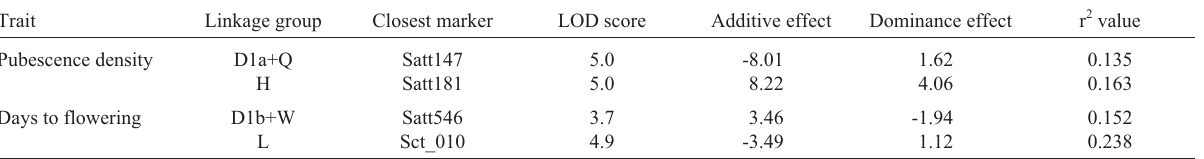
Table 1 - Positions and effects of quantitative trait loci (QTL) detected in the F 2 progeny of the Fukuyutaka x Himeshirazu cross. The Logarithm of odds (LOD)scorethresholdforQTLdetectionwas3.52forpubescencedensityand3.68forfloweringtime.Fortheadditiveeffectifthelocusisfixedwiththe maternal Fukuyutaka parent allele the trait value increases by the indicated value from the intermediate value between the parents. For the dominance effect if the locus is heterozygous the trait value increases by the indicated value from the intermediate value between the parents. The r 2 value represents the proportion of variance explained by the locus over the total phenotypic